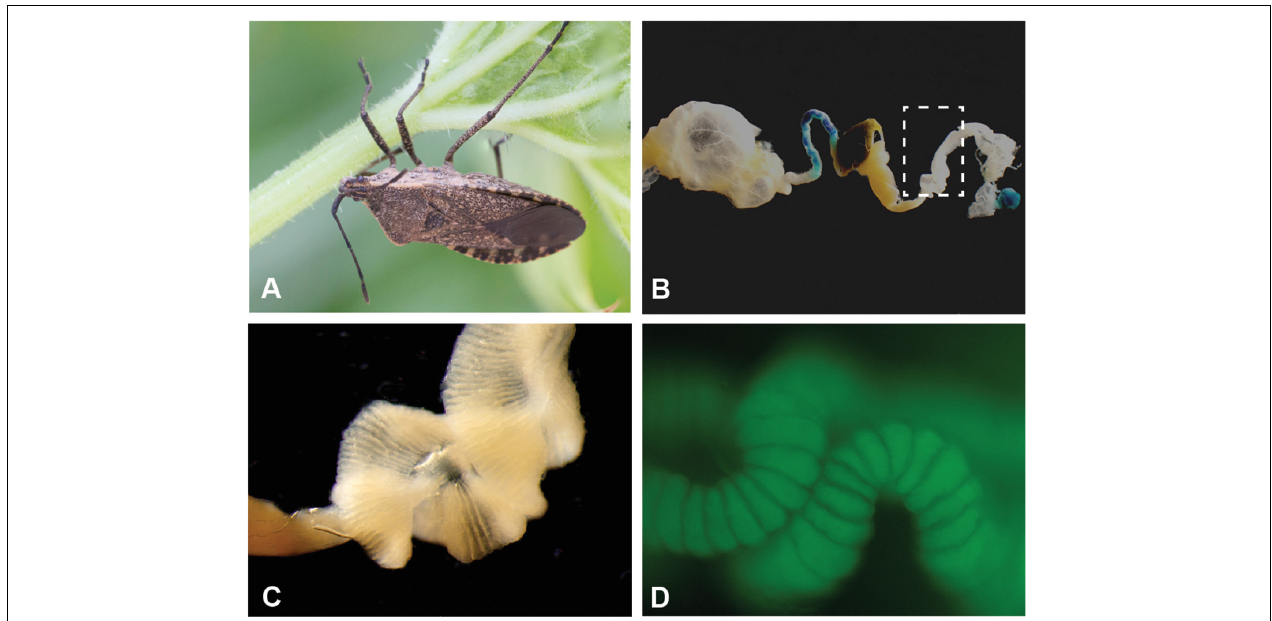
FIGURE 1 | Specialized midgut crypts of the agricultural pest Anasa tristis . (A) Adult A. tristis . (B) Entire midgut of adult A. tristis , with box highlighting M4 section. (C) Close-up of M4 section, which has the highly invaginated surface typical of midgut symbiont crypts in other true bug species. (D) Close up of crypts with GFP-labeled Caballeronia sp. bacteria. Additional images in Supplementary Figure 1